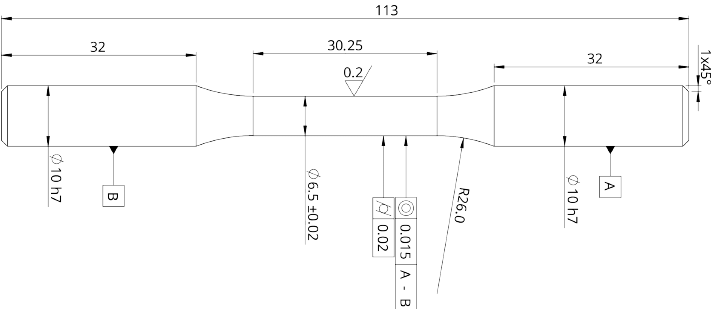
Figure 3. Illustration showing the specimen dimensions used in the experimental testing program, in accordance with ISO1143:2010 [29]. All dimensions are given in mm; the surface roughness is indicated in µ m.